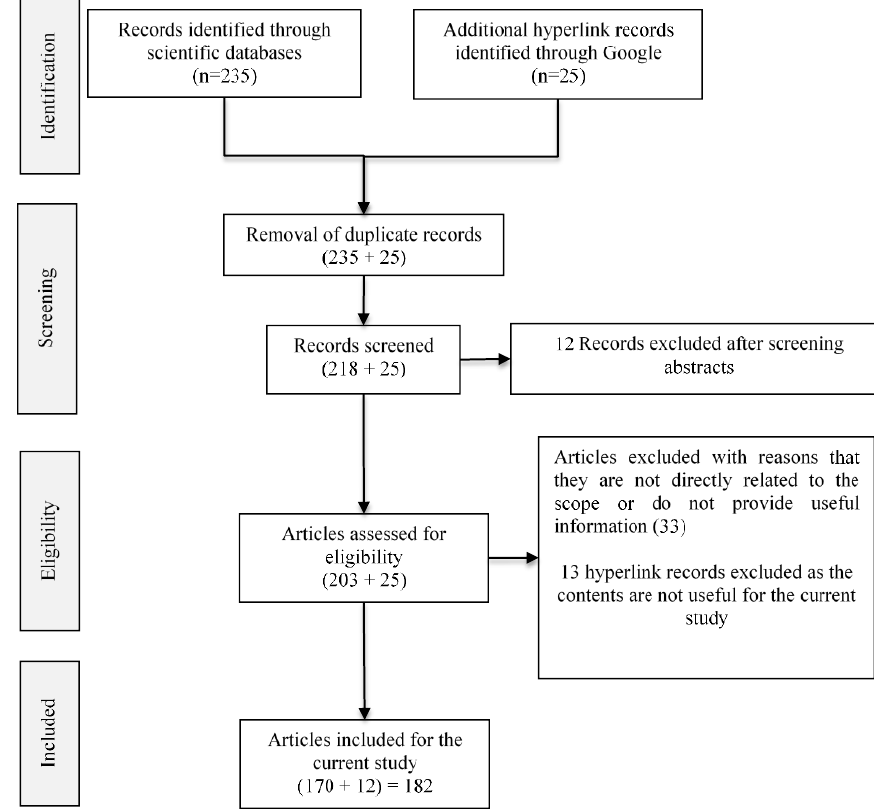
Figure 1. PRISMA flow diagram of the proposed review.